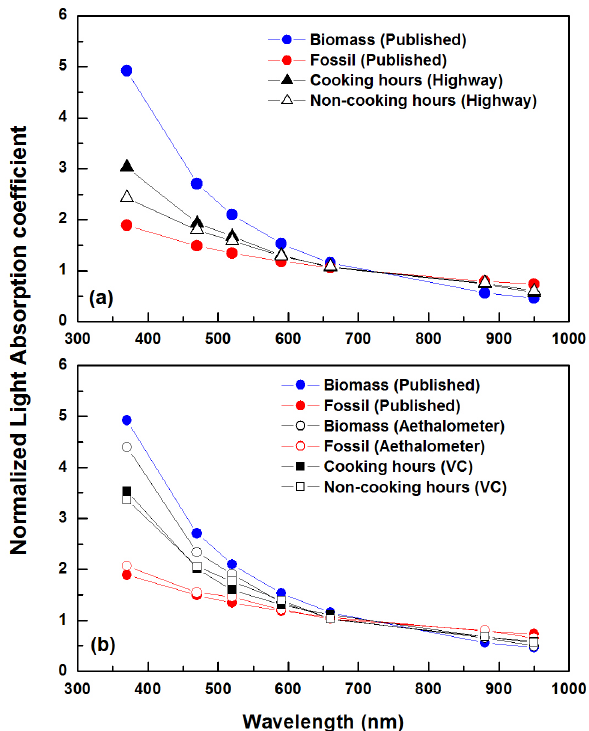
Fig. 9. Comparison of normalized light absorption coefficient of aerosol during cooking and non-cooking hours at (a) Highway and (b) SVI 1 village center (VC). Also show is earlier published (Kirchstetter et al., 2004) and the observed aethalometer response to biomass and fossil fuel combustion aerosols.